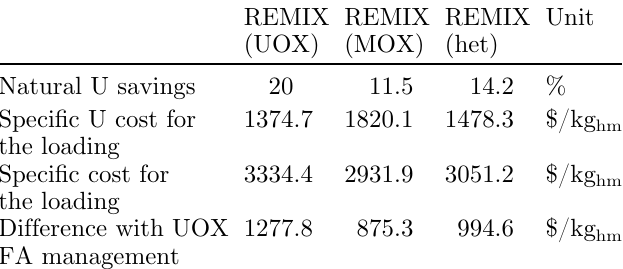
Table 5. The speci fi c cost for the fabricating process of the core loading (1st recycle).